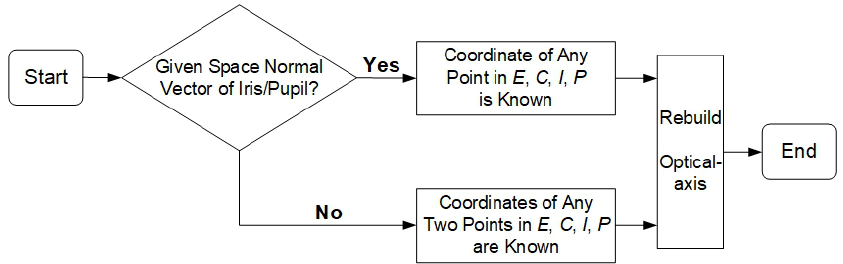
Figure 10. Human eyeball model.